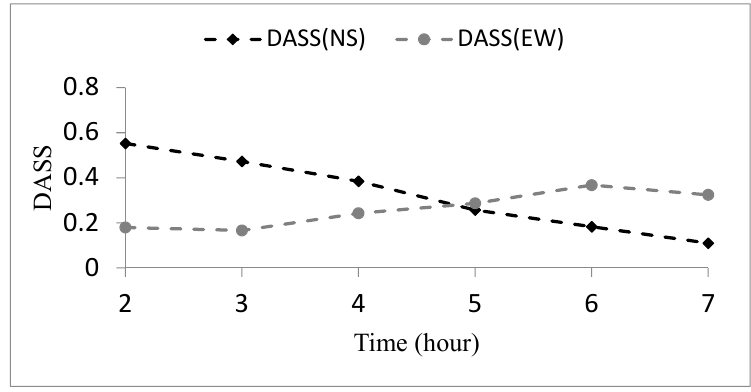
Figure 7. DASS of model NDA21 during 02:00–07:00 Julian Day 228.